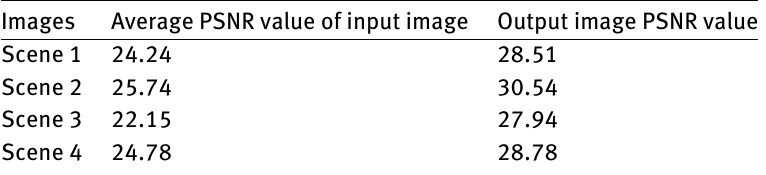
Table 4: PSNR value for the images